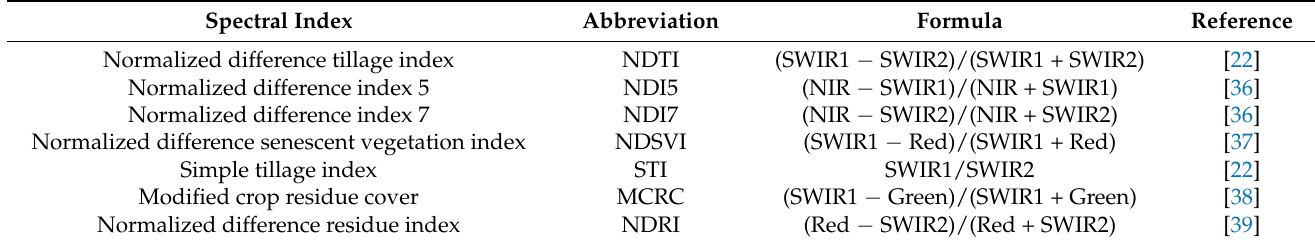
Table 3. Spectral indices used for CRC